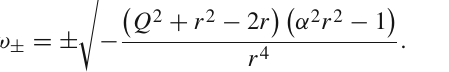
The metric limits are the RN solution and the C